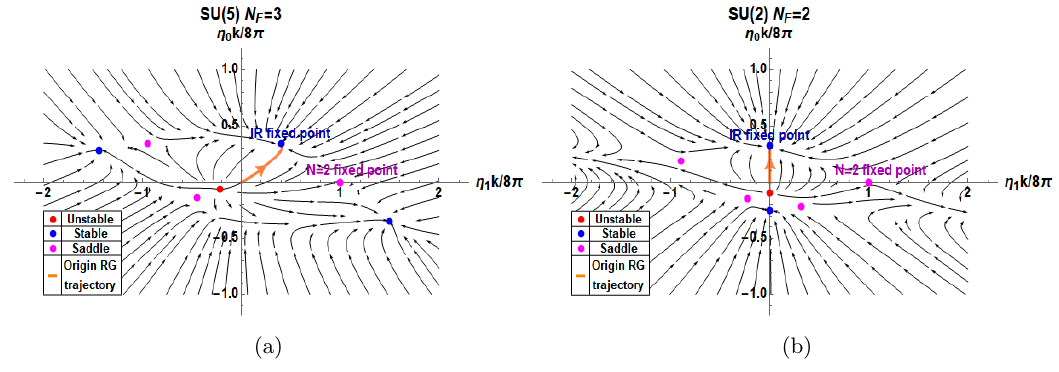
Figure 7 . RG (cid:13)ows for (a) SU(5) with N f = 3 and (b) SU(2) with N f = 2. These represent the general structure of the RG (cid:13)ows at large k . The N = 2 (cid:12)xed point is at (1 ; 0), which is a saddle point for N f (cid:21) 2. For N > 2 there is a stable N = 1 (cid:12)xed point in the (cid:12)rst quadrant, which attracts (cid:13)ows starting near the origin. For N = 2, a stable N = 1 (cid:12)xed point along the positive vertical axis attracts (cid:13)ows originating near (0 ;